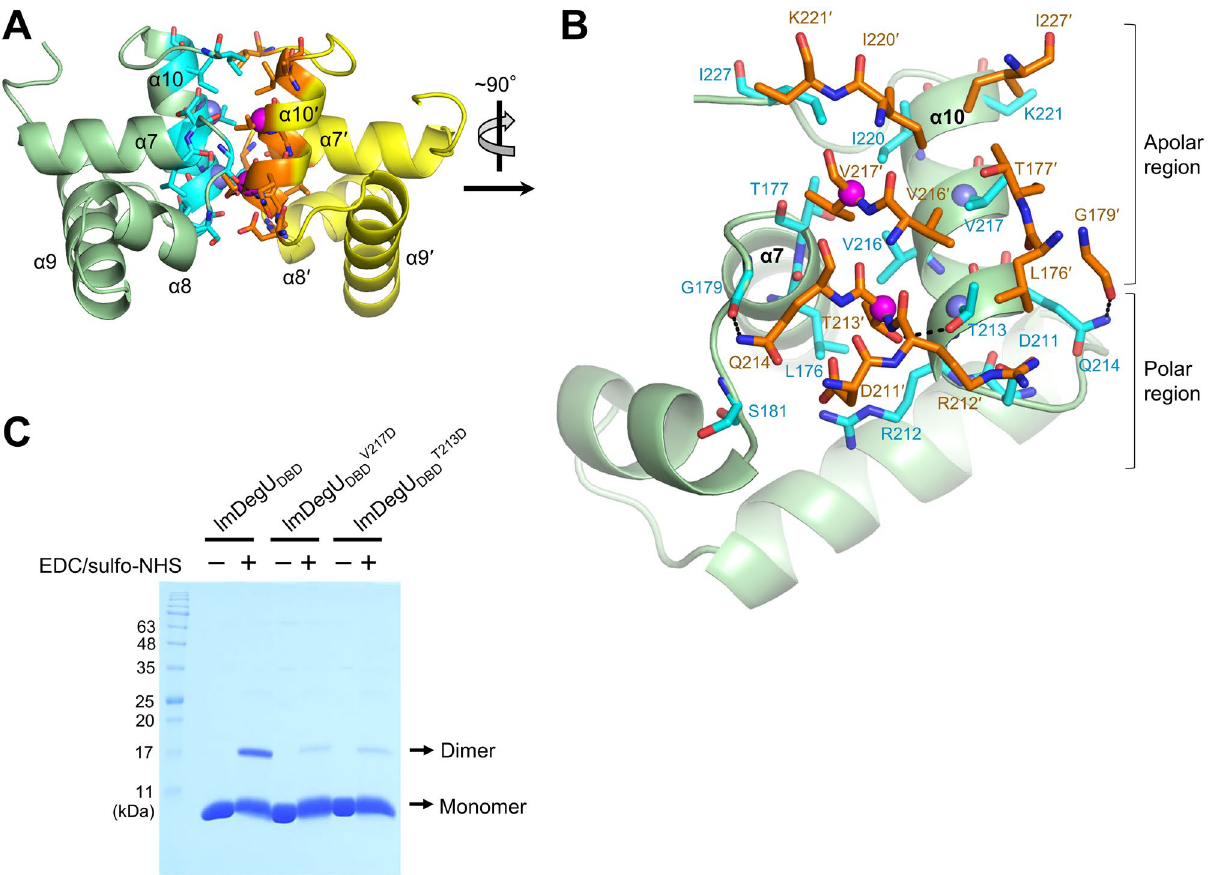
Figure 2. lmDegU DBD dimerization. ( A ) Dimeric structure of lmDegU DBD . The dimerization interface residues of lmDegU DBD are shown as cyan and orange sticks in the lmDegU DBD dimer structure (green and yellow ribbons). The T213 and V217 residues, which were mutated to confirm the dimerization interface of lmDegU DBD , are highlighted by light blue or magenta spheres. ( B ) lmDegU DBD residues in the dimerization interface. The dimerization interface residues from lmDegU DBD chains A and B are shown as cyan and orange sticks, respectively. lmDegU DBD chain A is depicted as green ribbons. Intermolecular hydrogen bonds are represented by dashed lines. The T213 and V217 residues, which were mutated to confirm the dimerization interface of lmDegU DBD , are highlighted by light blue or magenta spheres. ( C ) lmDegU DBD dimerization and its disruption by the mutation of dimerization interface residues (T213D and V217D). lmDegU DBD or its mutant was crosslinked using EDC and sulfo-NHS and analyzed by SDS-PAGE. Protein bands were identified by Coomassie brilliant blue staining. The gel image is representative of three independent experiments that yielded similar results. The full-length gel is shown in Supplementary Fig. S10. The V217D and T213D mutations do not seem to significantly modulate the folding of the lmDegU DBD protein, as lmDegU DBDV217D and lmDegU DBDT213D displayed CD spectra similar to that of lmDegU DBD (Supplementary Fig. S6). Moreover, lmDegU DBDV217D and lmDegU DBDT213D were eluted as single peaks in gel-filtration chromatography in elution volumes similar to that of lmDegU DBD (Supplementary Fig.